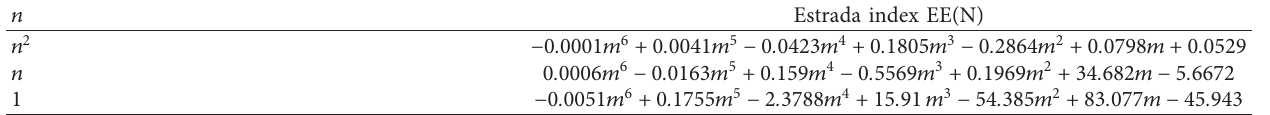
Table 10: The EE indices of the naphthalene. ( m, n )